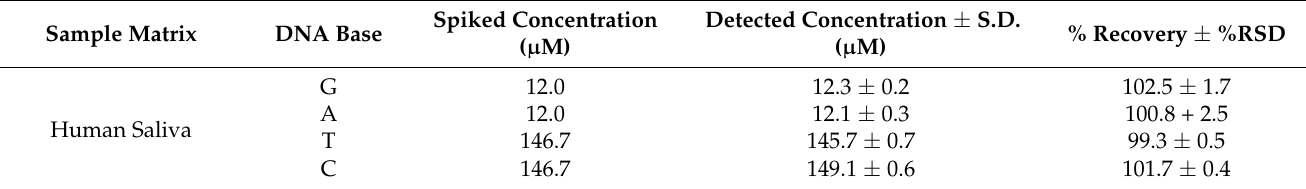
Table 4. Detected concentrations and the recovery for the simultaneous detection of the four DNA bases using the GC-SC-MB (n = 3).